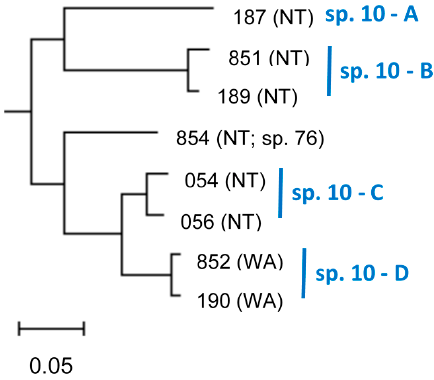
Figure 10. Extract from the full CO1 tree (Figure S1)—III. The clade represents species from Group D occurring in northwestern Australia. Specimens sorted as Melophorus sp. 10 (Group D) likely represent four species (A–D). NT = Northern Territory; WA = Western Australia.